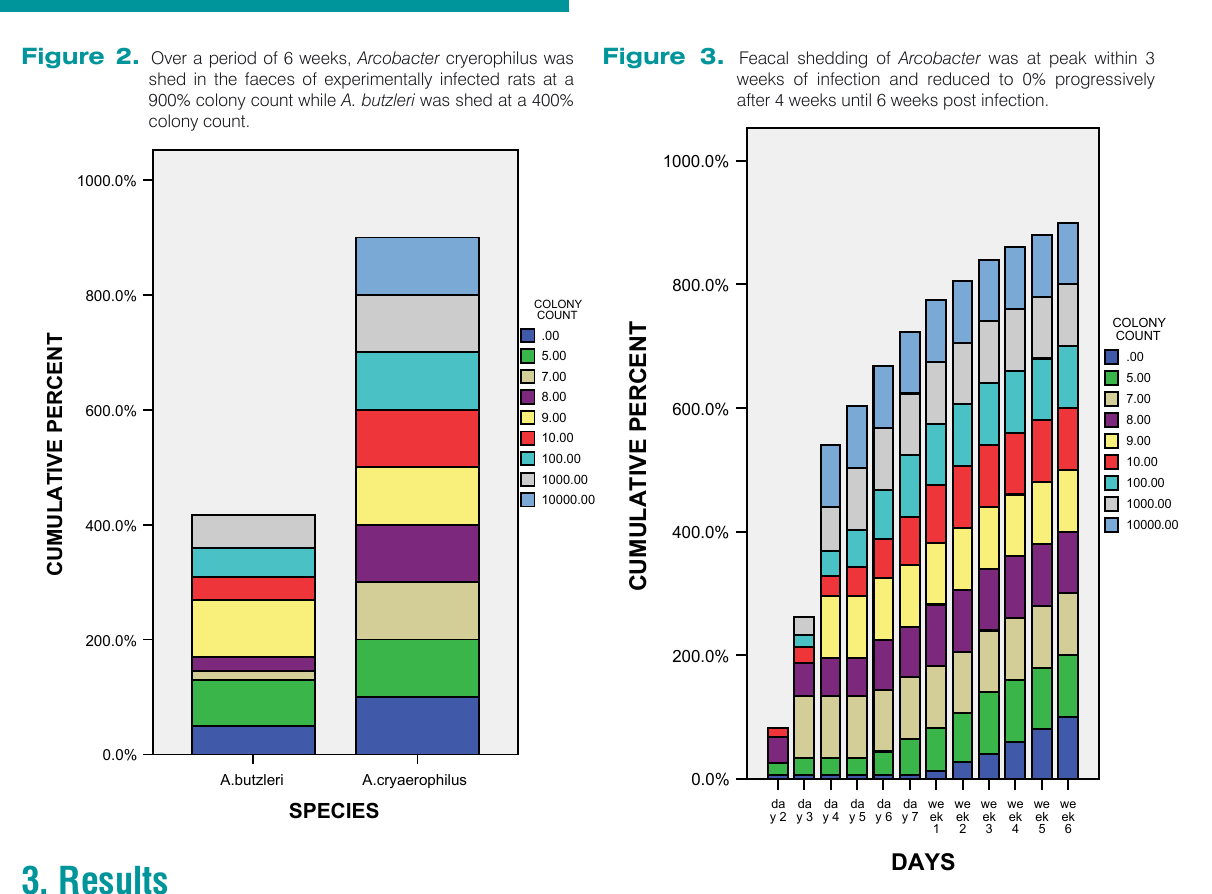
Figure 3. Feacal shedding of Arcobacter was at peak within 3 weeks of infection and reduced to 0% progressively after 4 weeks until 6 weeks post